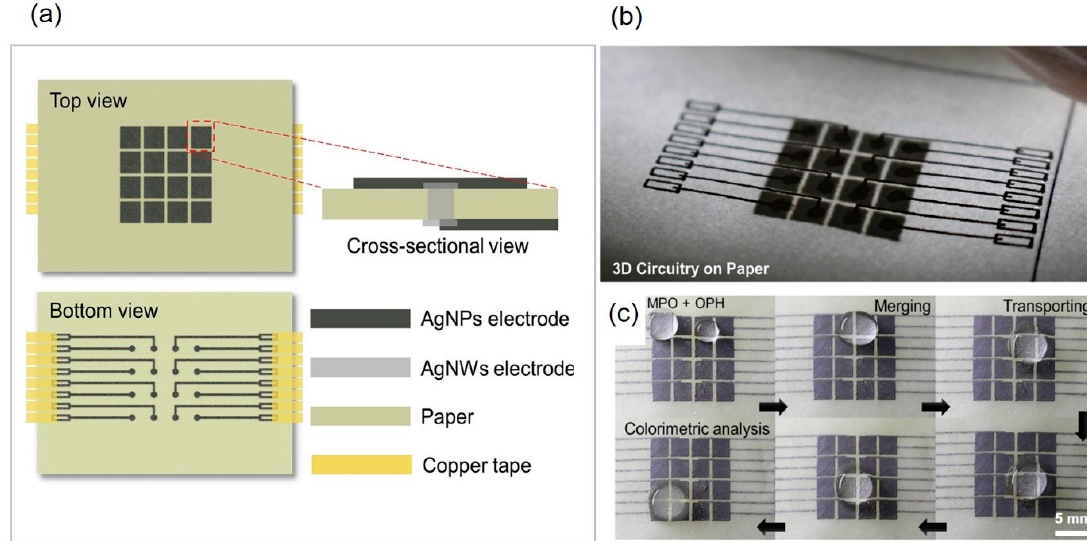
Figure 6. ( a ) Schematic illustration of the fabrication of two-dimensional electrode arrays for a p-DMF device, ( b ) photograph of the printed p-DMF device showing the 3D circuitry over an LED lamp, ( c ) the p-DMF device showing merging, mixing, and transport functions. Reproduced with permission from the authors of [82]. Copyright 2018, Elsevier B.V.